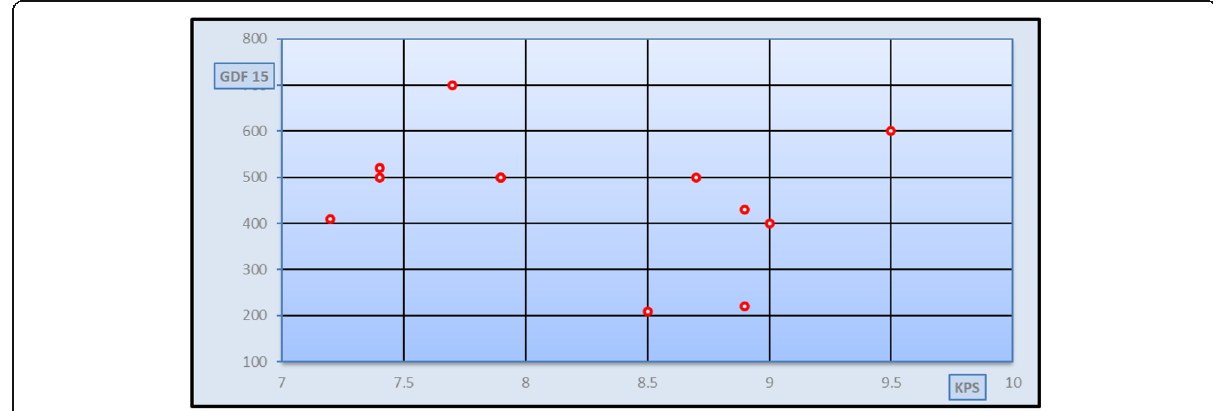
Fig. 3 Correlation study between GDF-15 and fibroscan in KPS in group II patients [ r = − 0.251 and p = 0.409 (non-significant)]